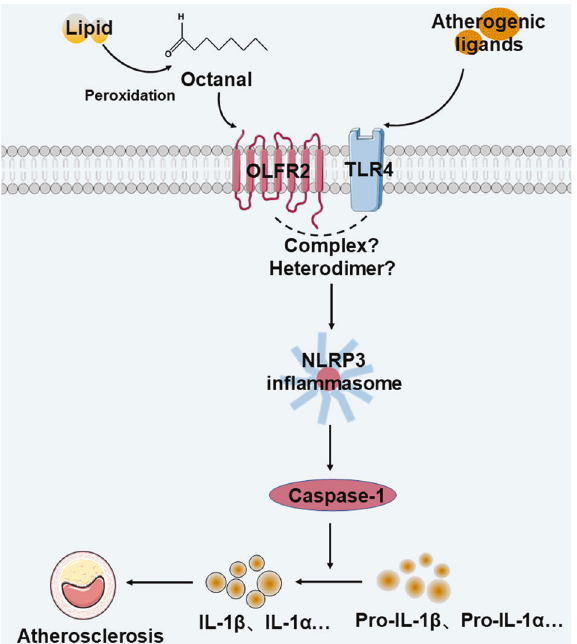
Fig. 1 Schematic showing mechanisms of OLFR2 ligation-mediated signaling promoting atherosclerosis. Endogenous atherogenic ligands activate TLR4 and subsequently initiate the priming signal of the NLRP3 in fl ammasome. Octanal derived from oxLDL activates the OLFR2 and the downstream NLRP3 in fl ammasome activation, which triggers in fl ammatory cytokine interleukin release, leading to the progression of atherosclerosis. OLFR2 olfactory receptor 2, TLR4 Toll-like receptor 4, NLRP3 NLR family pyrin domain-containing 3, oxLDL oxidized low-density lipoprotein, IL-1 β interleukin-1 β , IL-1 α interleukin-1 α . This fi gure was designed using